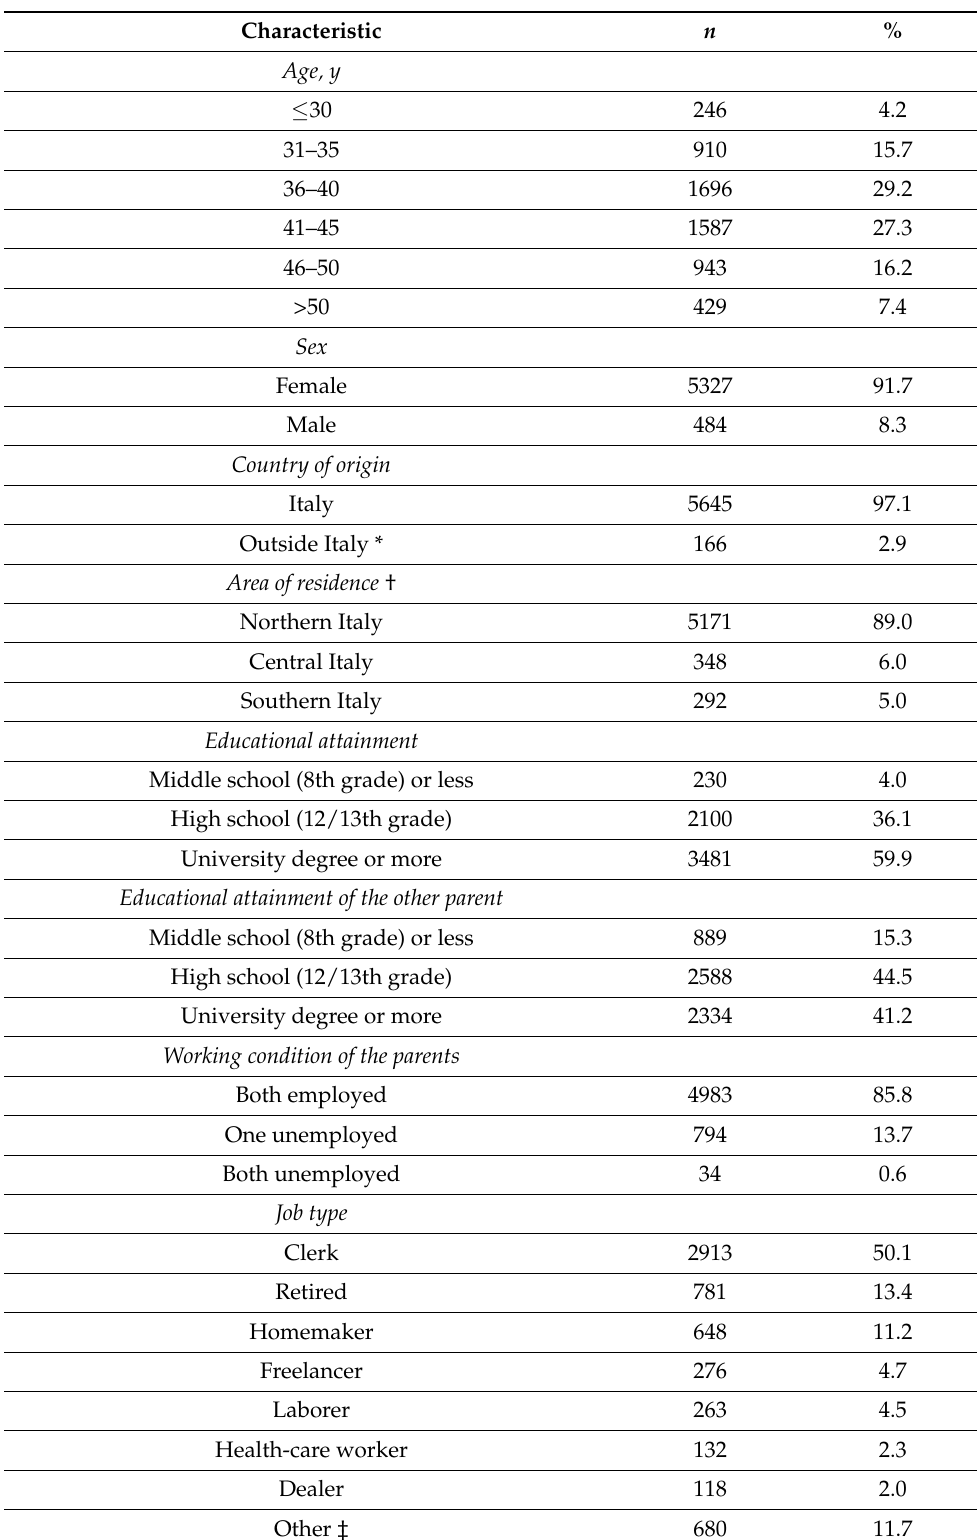
Table 1. Sociodemographic characteristics of the study sample ( n −